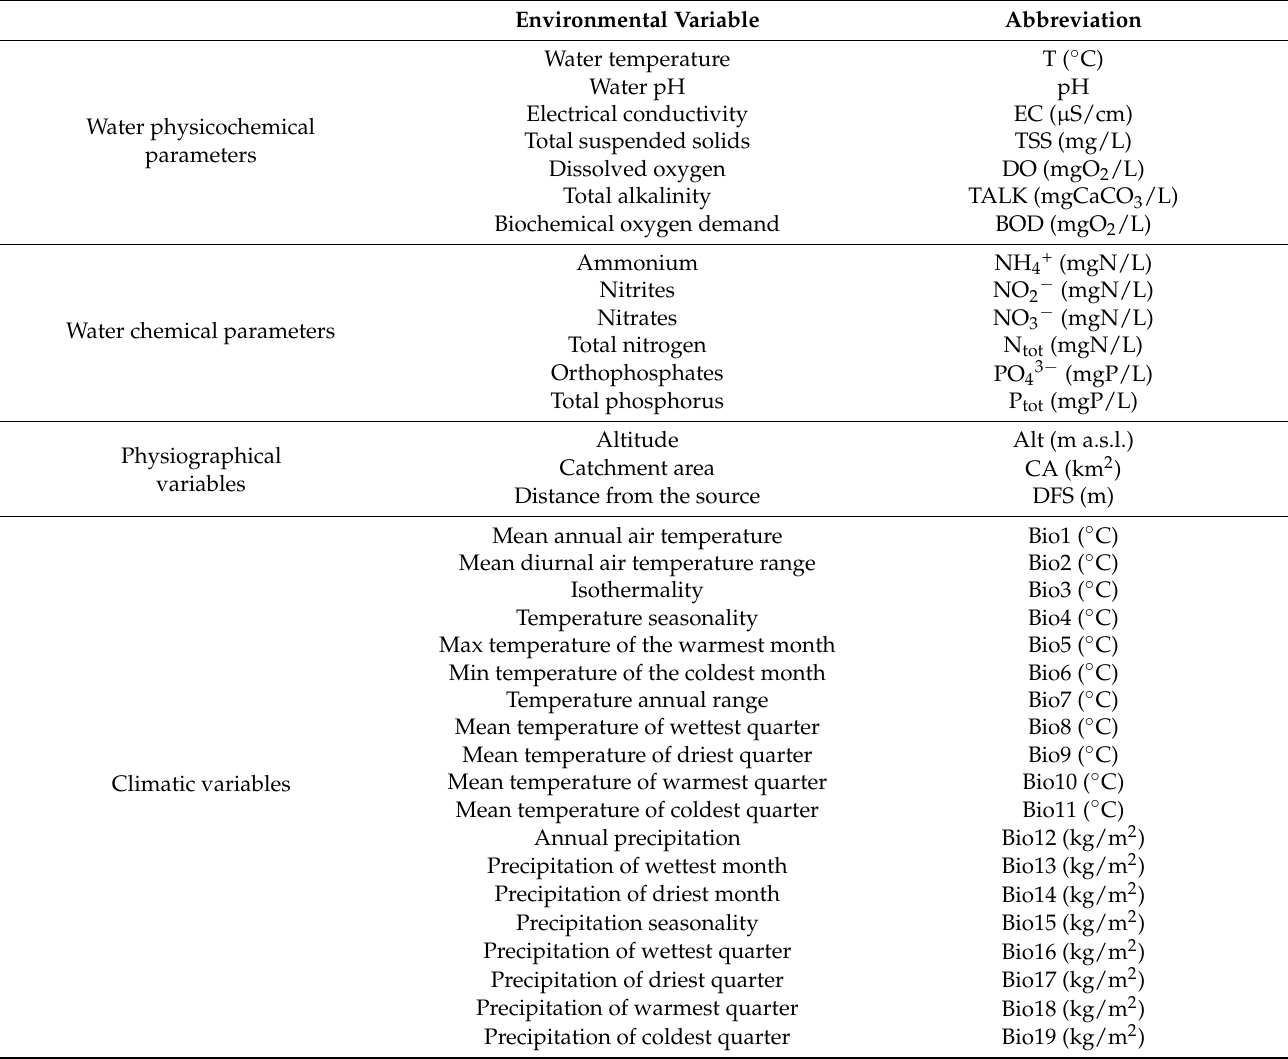
Table 5. Environmental variables and abbreviations